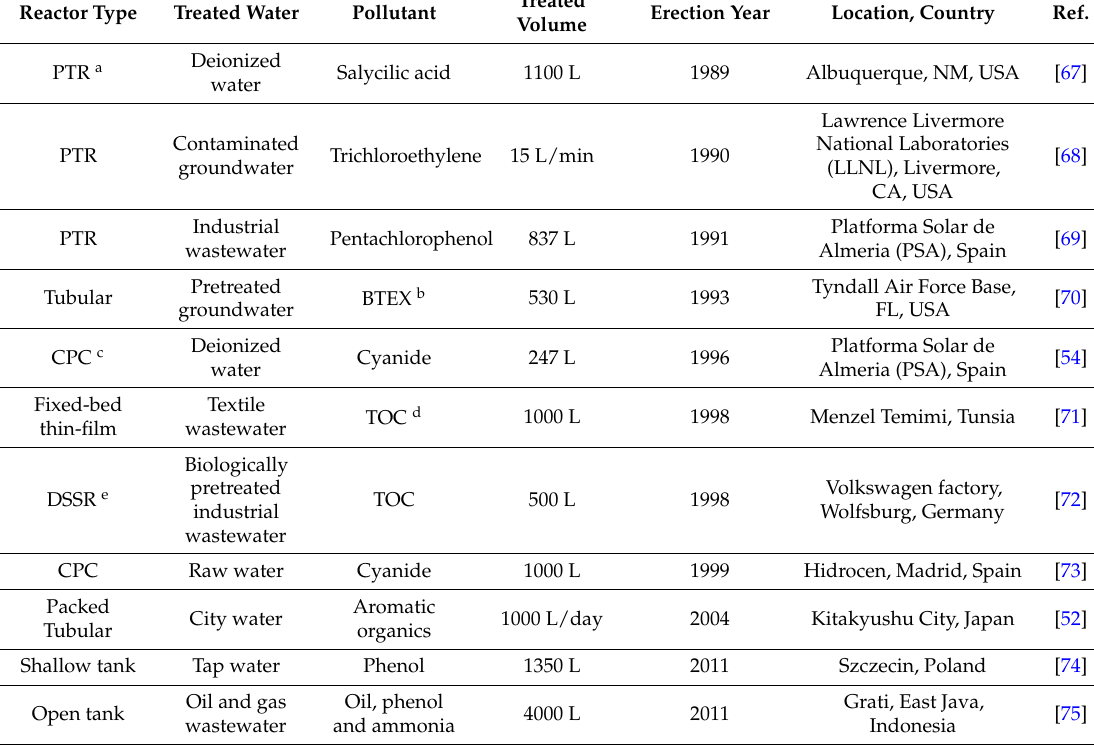
Table 1. Solar TiO 2 pilot and demonstration